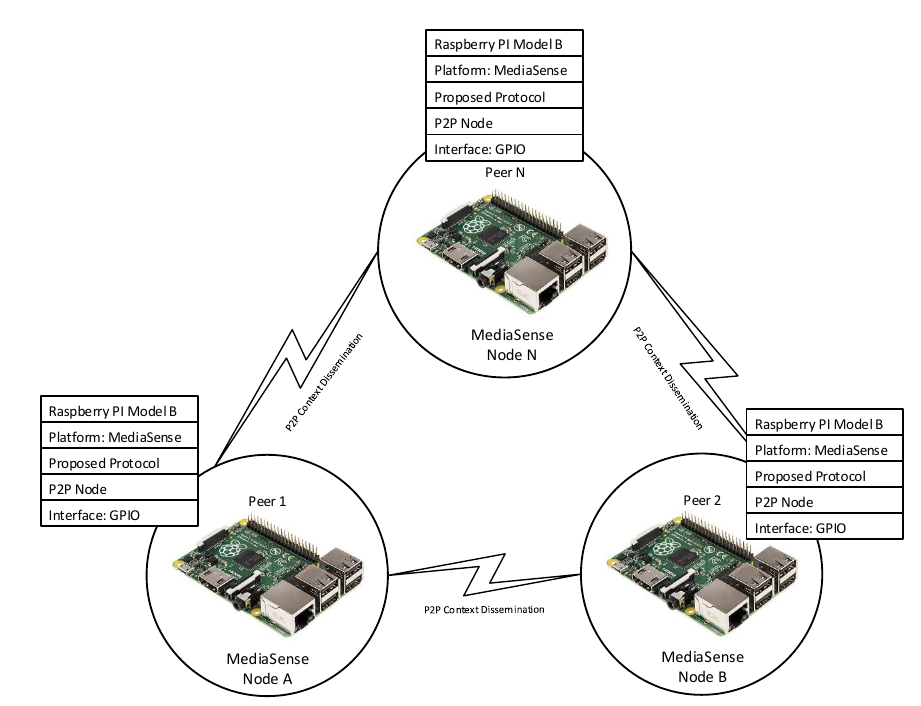
Figure 7. Peer-to-peer Network Configuration